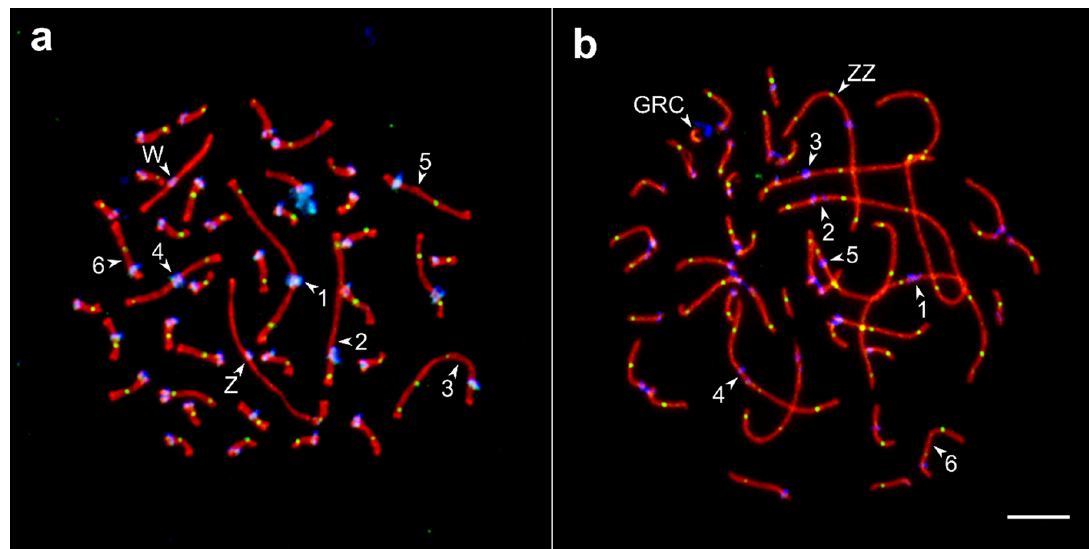
Figure 1. Synaptonemal complexes (SC) spreads of the oocyte ( a ) and spermatocyte ( b ) of the barn swallow after immunolocalization of the lateral elements of the SC (SYCP3—red signal), recombination nodules (MLH1—green), and centromeres (ANA-C—blue). Numbers indicate SCs of